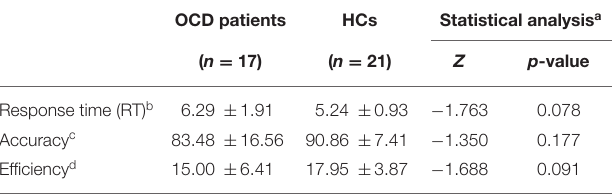
TABLE 2 | Behavioral performance during the mental rotation task in patients with obsessive-compulsive disorder (OCD) and healthy controls (HCs). OCD patients HCs Statistical analysis